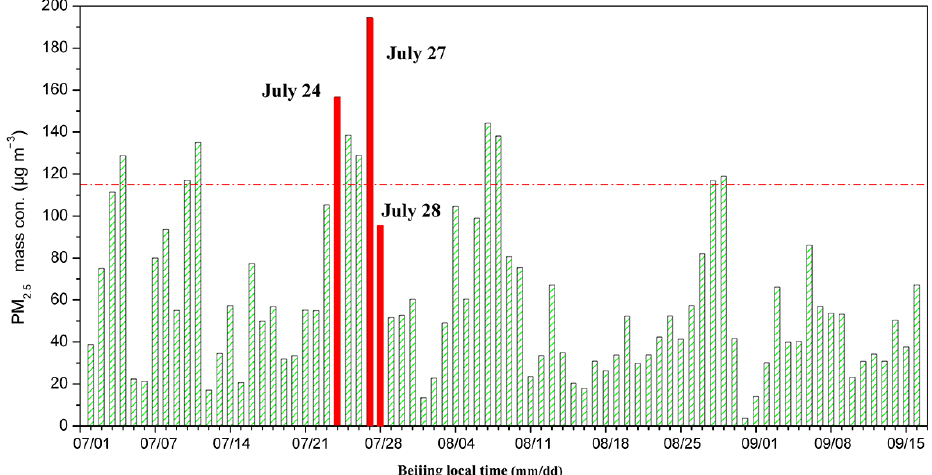
Figure 1. Daily variation of the PM 2 . 5 concentration between July and September 2008 at IAP. The dotted line represents the definition of a moderate pollution day (PM 2 . 5 = 115µgm − 3 ) , and 24, 27 and 28 July are highlighted.